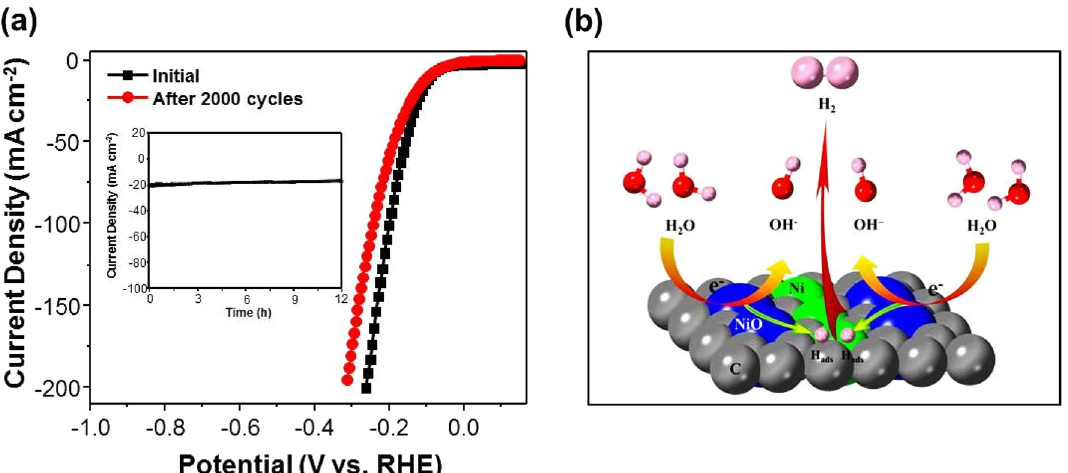
Fig. 6 a Polarization curves recorded initially and after 2000 CV cycles of H–Ni/NiO/C. Inset: Current–time response of H–Ni/NiO/C obtained at 0.198 V for 12 h. b Schematic of the proposed HER mechanism using the H–Ni/NiO/C −